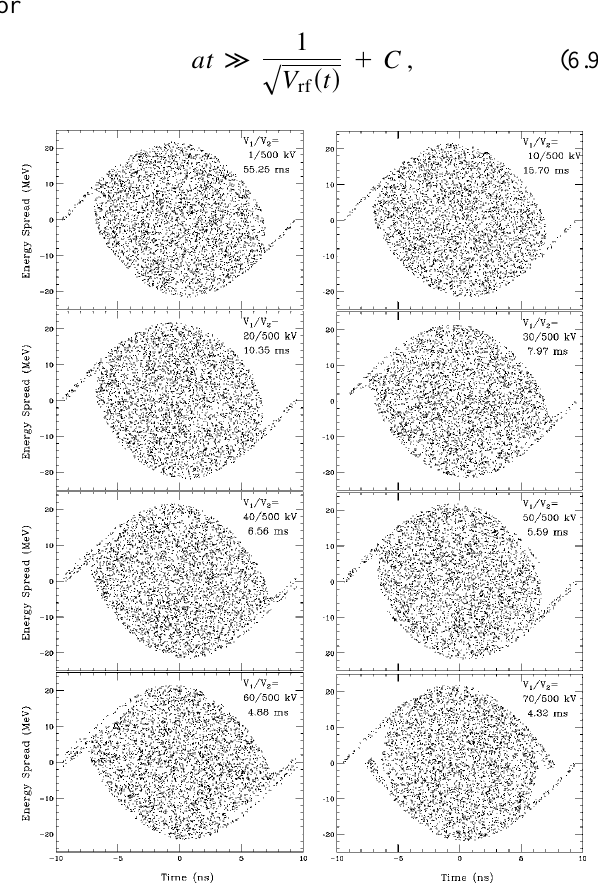
FIG. 11. Plot of a 53 MHz bunch in the longitudinal phase space after adiabatic capture starting from various initial rf voltage V 1 to the final V 2 (cid:1) 500 kV. Adiabatic- ity is fixed at n (cid:1) 10 and the initial bunch area is 2 3 12 3 11.134 (cid:1) 588 (cid:1) 0.4544 eV s. At V 2 (cid:1) 500 kV, the final half bunch height is 21.65 MeV and half width 7.28 ns when matched to the rf bucket.